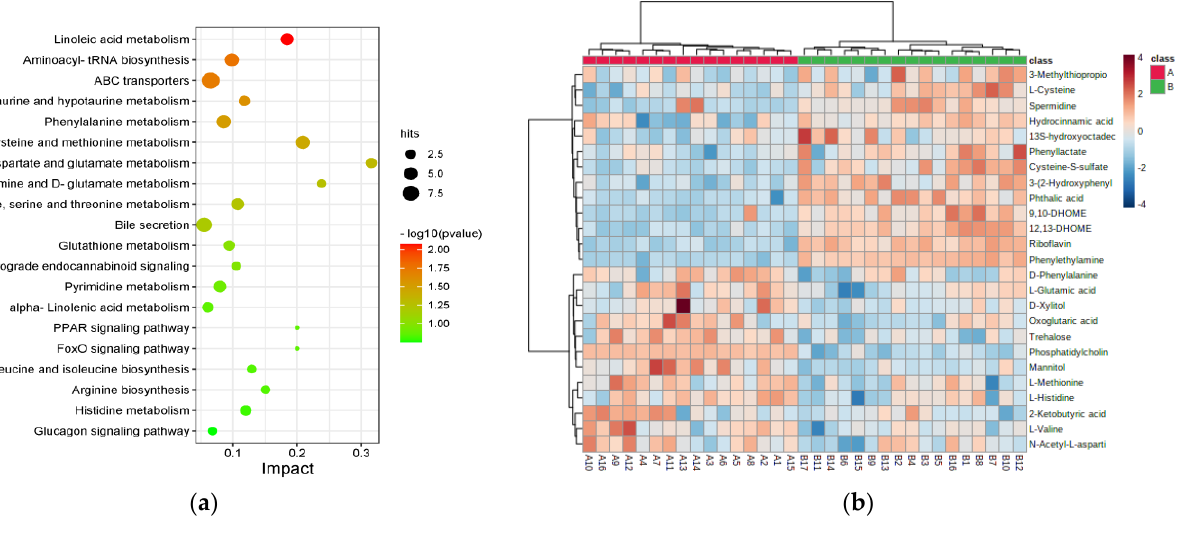
Figure 2. Disturbed metabolic pathways and heatmap of preliminarily selected 25 differential metabolites between the GV-H and GV-L groups in the exploratory set. Bubble diagram of differential metabolic pathways between the GV-H and GV-L groups ( a ). Each point represents a pathway, the abscissa is the Impact value, and the ordinate is the enriched pathway. The dots indicate the number of metabolic molecules corresponding to the pathway. The color is related to the P value, the redder the color, the smaller the P value. Heatmap of preliminarily selected 25 differential metabolites ( b ). Each row represents a metabolite, and each column depicts a subject. Group A is the GV-L group and group B is the GV-H group; the peak intensity of a metabolite is shown by different colors, namely, the redder the color, the higher the peak intensity. Table 2. Candidate novel GV biomarkers identified in seven differential metabolic